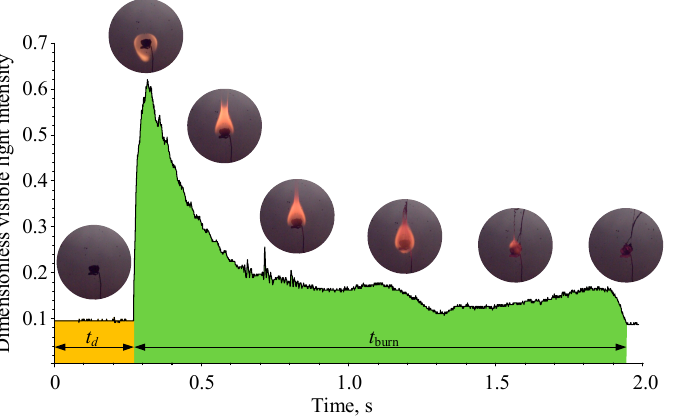
Figure 2. Visualization of the video frame processing for determining the fuel ignition delay times. The developed processing algorithm controlled the values of visible light emission intensity frame by frame in the entire video recording area. The ignition moment was determined automatically by a sharp jump in the luminosity intensity in the controlled vicinity of the fuel droplet (Figure 2). The burnout time of a fuel droplet ( t burn ) was recorded from the ignition moment to the end of combustion, which was characterized by a decrease in the glow intensity to the initial level—the luminosity value before fuel ignition (Figure 2). The systematic and random uncertainties of t d and t burn connected with the video recording speed and the scatter of experimental data did not exceed 0.5% and 10%, respectively.